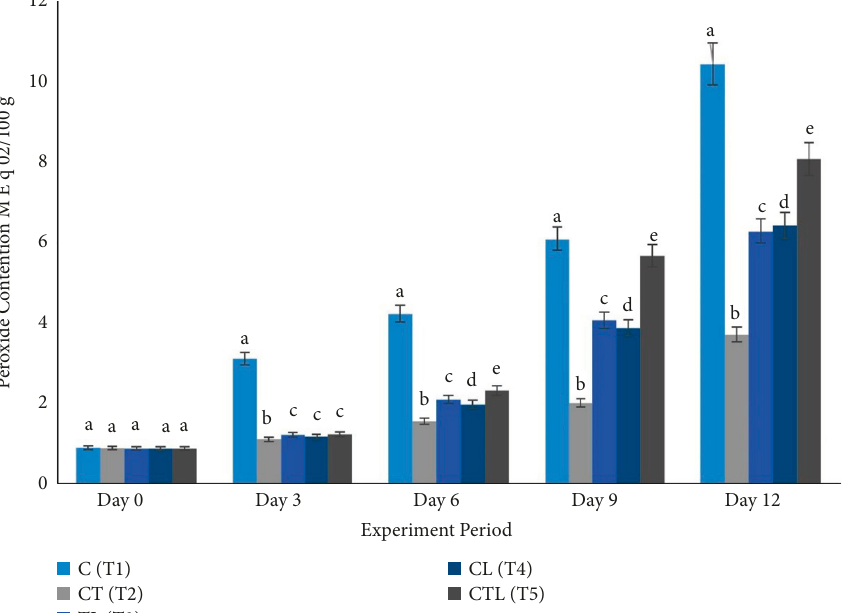
Figure 6: Percentage of peroxide content in the carp fillet immersed in mixed different extracts of turmeric, cinnamon, and lemon at 4 °